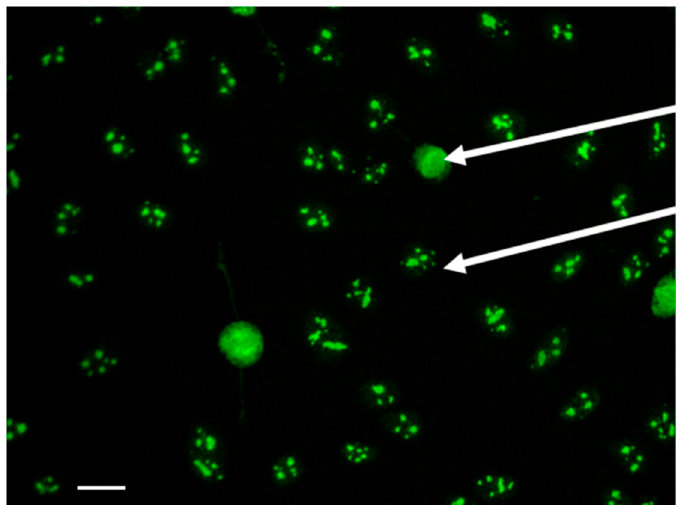
Figure 1 . Typical fluorescence pattern of antifibrillarin antibodies by indirect immunofluorescence on HEp-2 cells. The upper arrow depicts the reticular staining of a metaphase cell. The lower arrow shows clumpy nucleolar staining with fluorescent coilin bodies in an interphase cell. Scale bar: 20 µm